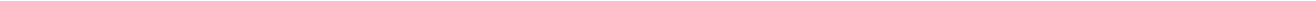
Fig. 1 Kras -mutant tumor cells exhibit non-canonical endogenous NF- κΒ activity. Five different C57BL/6 mouse tumor cell lines with ( Kras MUT : LLC, MC38, AE17) or without ( Kras WT : B16F10, PANO2) Kras mutations were assessed for activation and inhibition of resting NF- κΒ activity in vitro. a Map of NF-